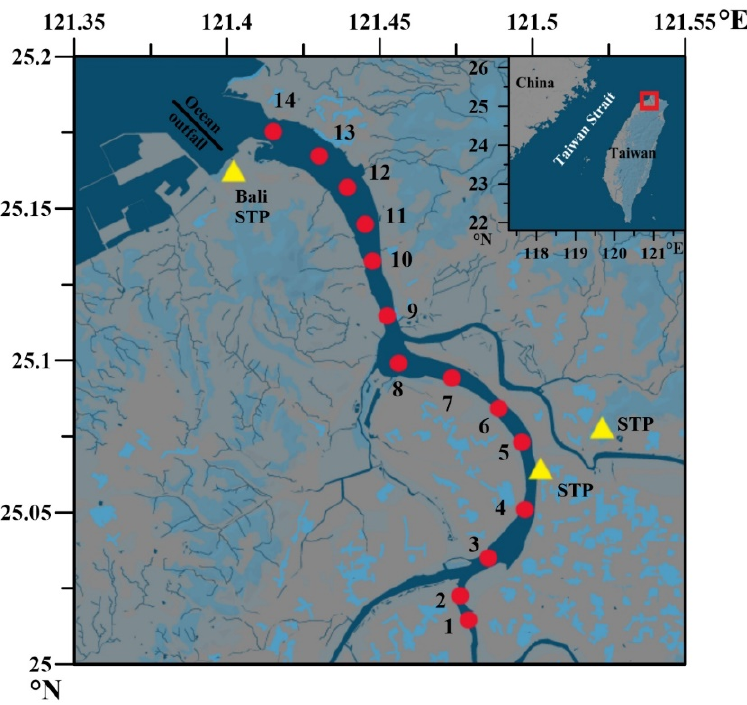
Figure 1. Sampling stations (1–14) along the Danshuei River Estuary in northern Taiwan. (STP: sewage treatment